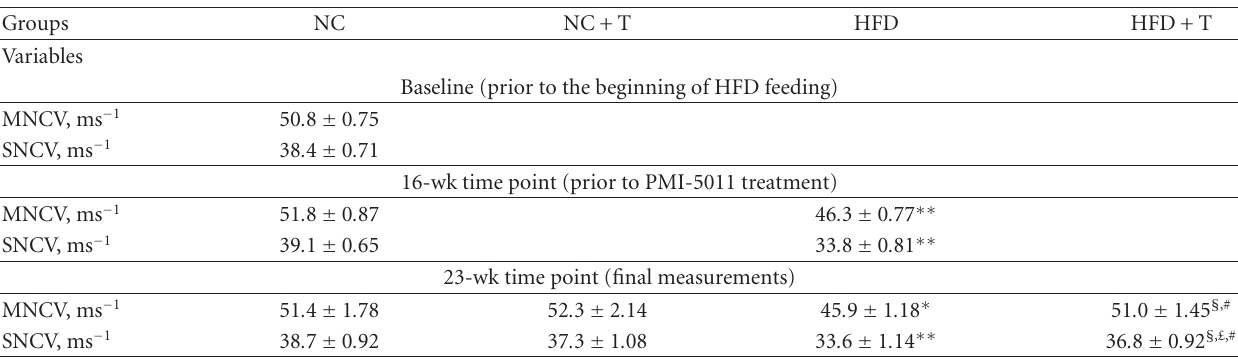
Table 2: Motor and sensory nerve conduction velocities in normal chow and high fat diet-fed mice maintained with and without PMI-5011 treatment.